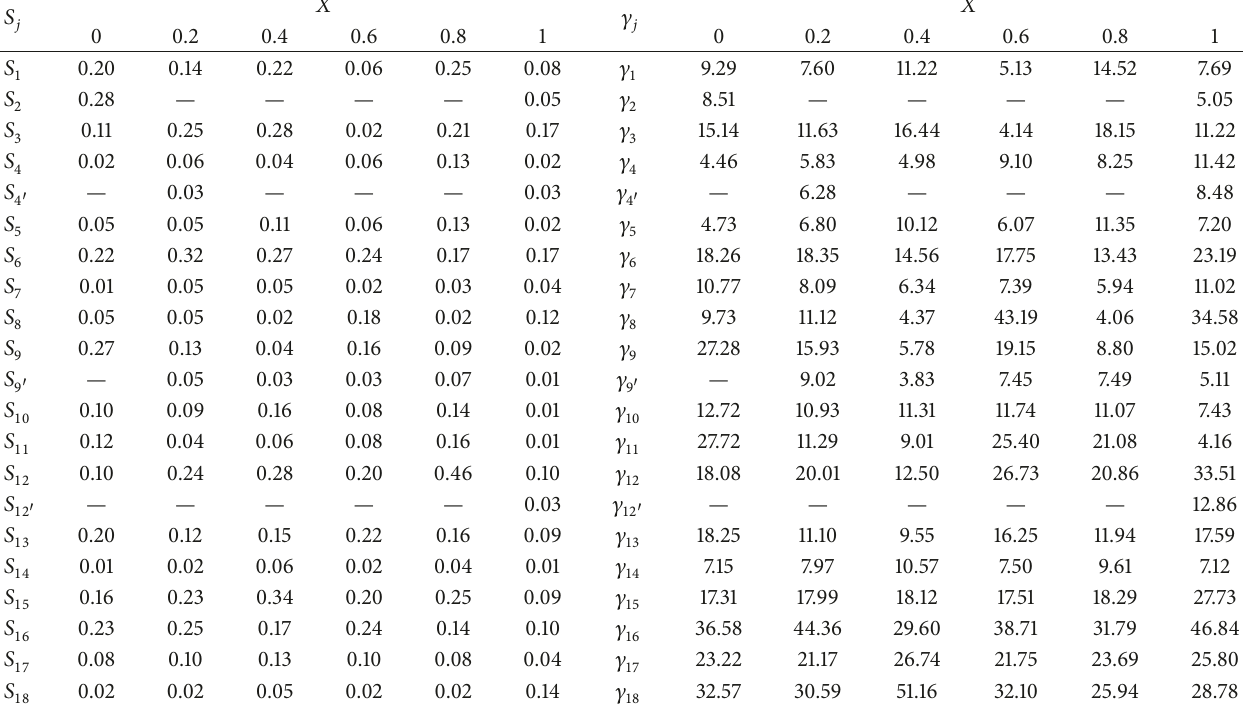
Table 3: Phonon-fit values of oscillator strength ( 𝑆 𝑗 ) and damping factor ( 𝛾 𝑗 ) of Gd 1−𝑥 Y 𝑥 Mn 2 O 5 with 𝑥 = 0, 0.2, 0.4, 0.6, 0.8, and 1 at room